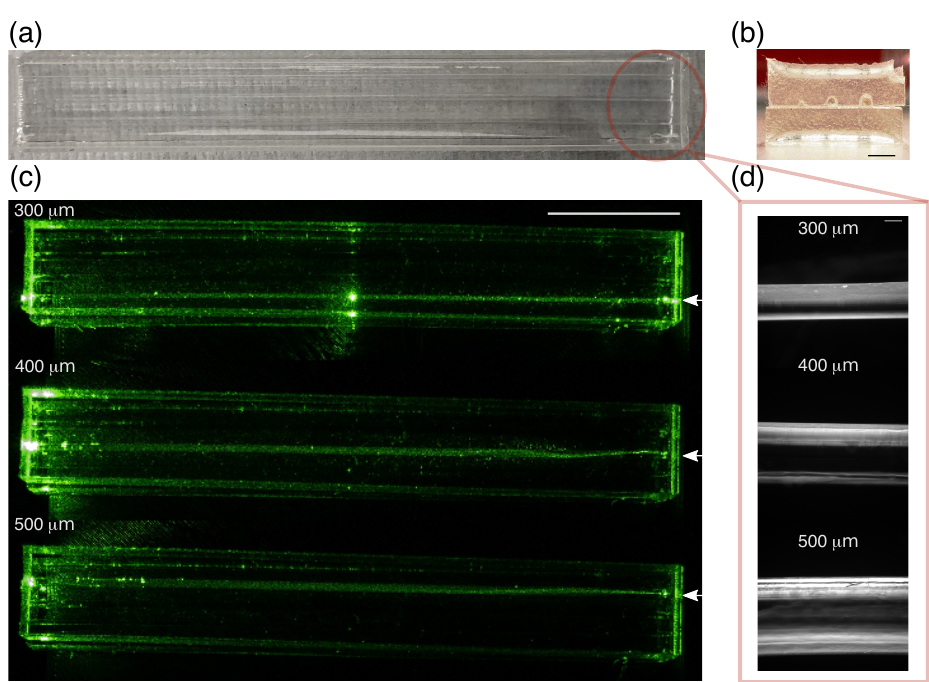
Figure 5. ( a ) Photograph of the PEGDA waveguides embedded in polydimethylsiloxane (PDMS). Three PEGDA 700, 90% waveguides with different radii were embedded in a single PDMS block for waveguiding tests and cut-back measurements; ( b ) Photo of the cross-section of the waveguide. Scale bar is 20 mm; ( c ) Representative photos of a fabricated 10 cm straight waveguide in a PDMS cladding with the 532 nm laser guided along the PEGDA 700, 90% core. The focused laser is incident to the waveguide marked by the arrow. Scale bar is 25 mm; ( d ) Microscope images of the fibers fabricated by filling the PDMS channels with PEGDA 700, 90% with different radii. Scale bar is 300 µ